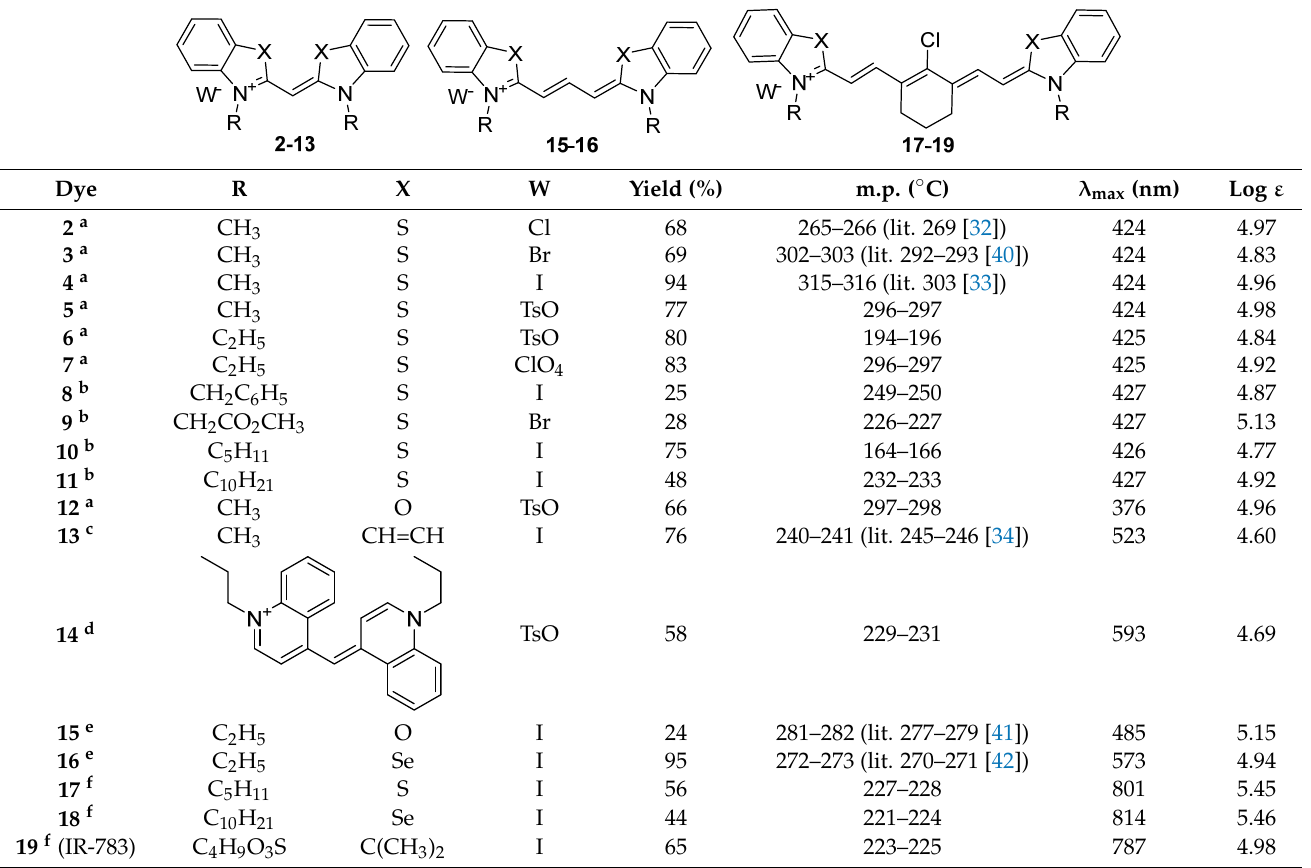
Table 1. Structure, yield, melting point (m.p.), wavelength of maximum absorption (ethanol), and molar extinction coefficient values of the cyanine dyes 2 – 19 .